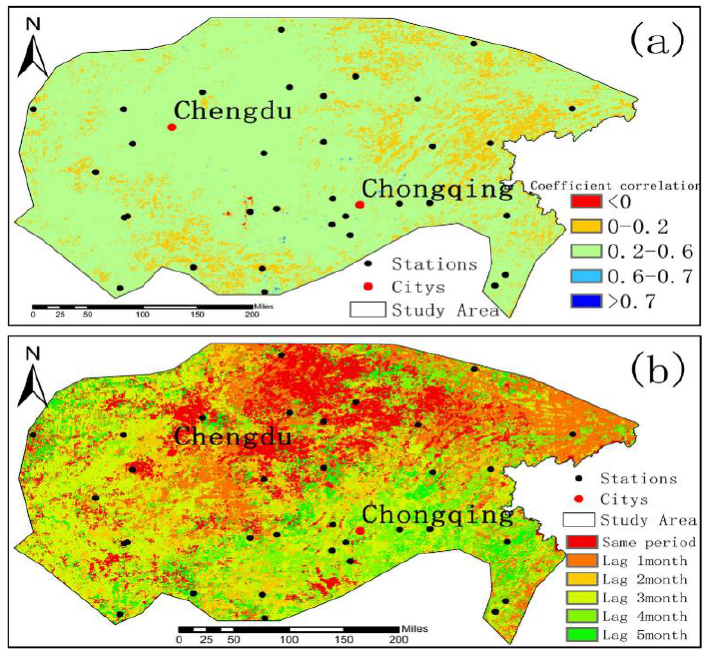
Figure 9. Spatial distribution of maximum cross-correlation ( a ) between NDVI and humidity index and time-lag response ( b ) in the Sichuan region.